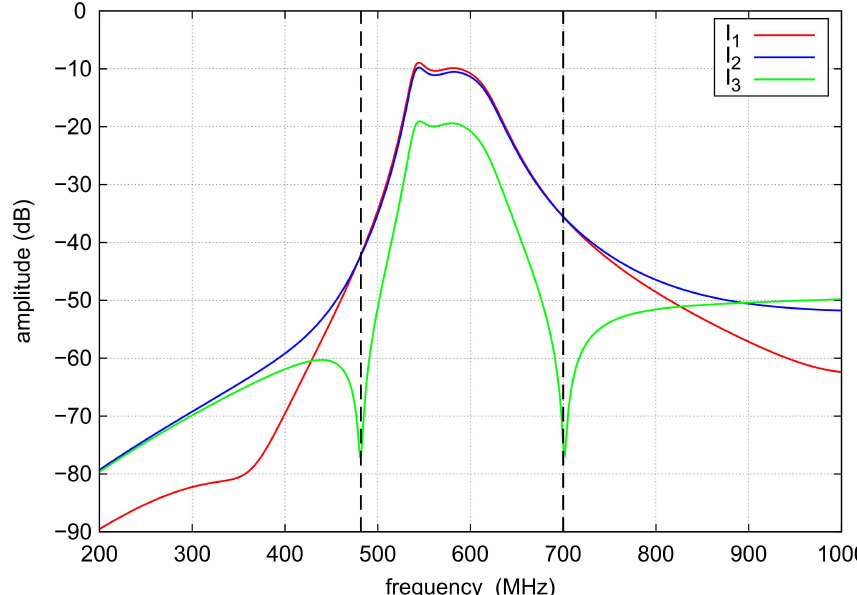
Figure 21. Amplitudes of the currents flowing through the output node.